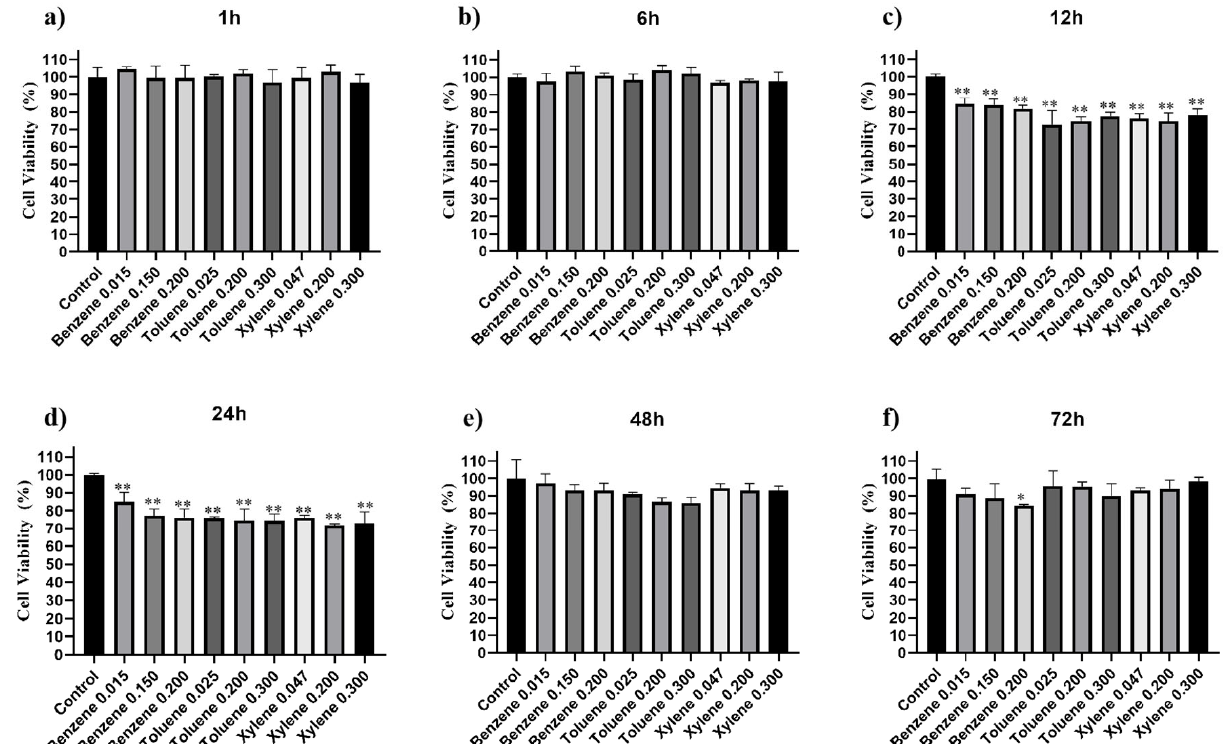
Figure 2. Cell viability test under different concentrations of BTX (see detailed concentrations in Table 2) and different incubation times. All BTX was dissolved in DMSO before added into BEAS-2B cell culture medium. The ratio of DMSO to cell culture medium is 0.05%. * p < 0.05 and ** p < 0.01.